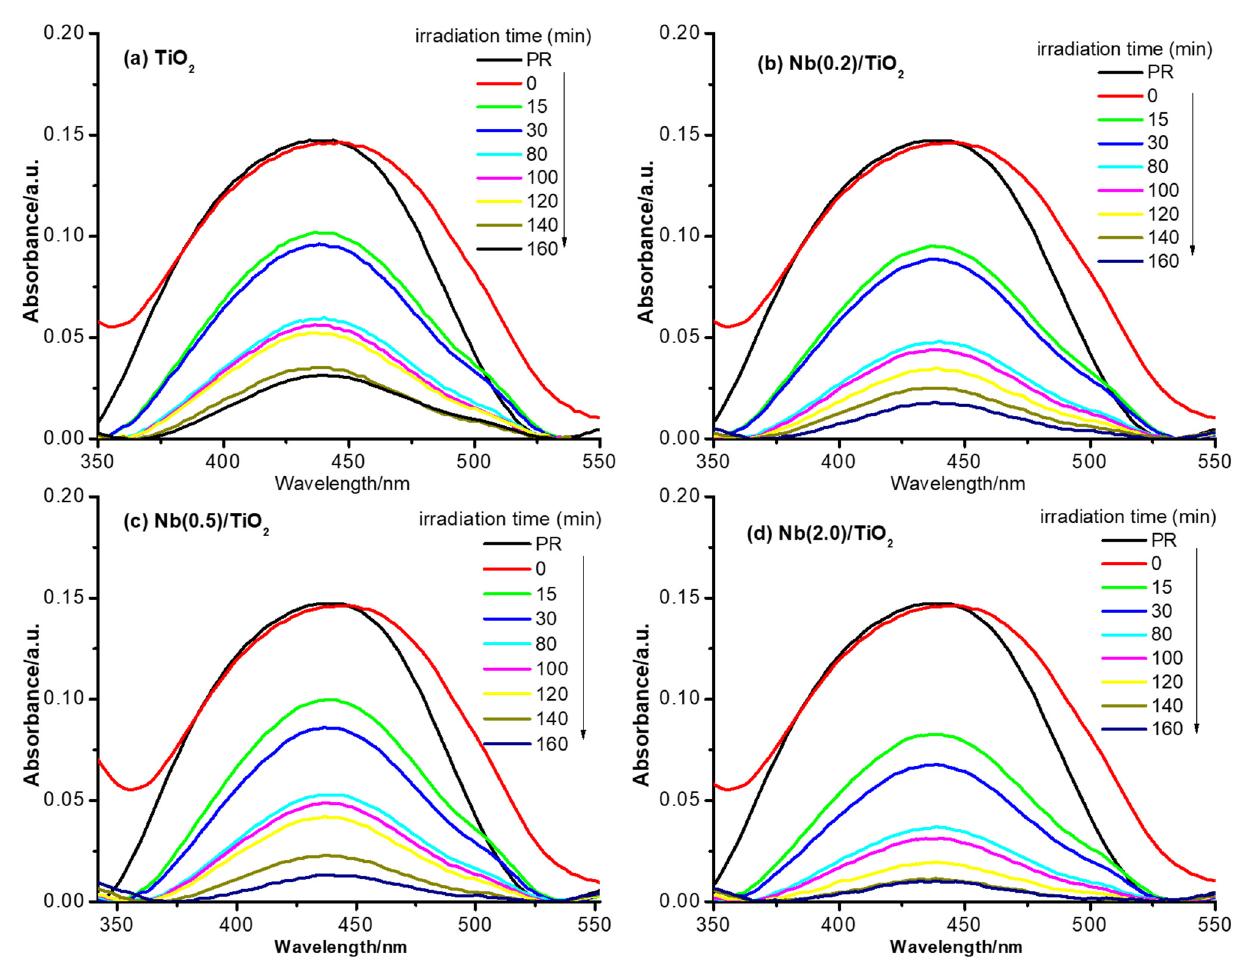
Figure 7. Absorbance spectra of the degradable phenol red at various irradiation times for TiO 2 , Nb(0.2)/TiO 2 , Nb(0.5)/TiO 2, and Nb(2.0)/TiO 2 Nb(0.2)/TiO 2 , Nb(0.5)/TiO 2, and Nb(2.0)/TiO 2 .